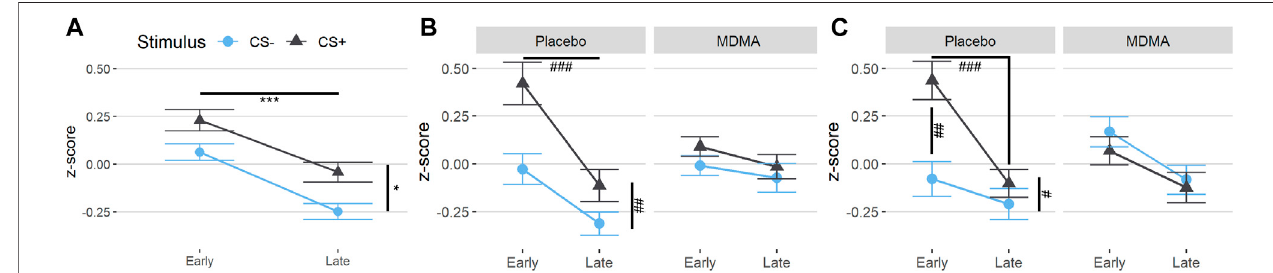
FIGURE 2 | MDMA treatment reduces CS+/CS − discrimination during fear extinction learning and enhances extinction recall. Standardized values (z-scores) of both trial types (conditioned fear stimulus [CS+] and conditioned safety stimulus [CS − ]) of the skin conductance response task. (A) Subjects showed differentiation between CS+ and CS − in acquisition. (B) In the extinction learning phase, subjects after a placebo displayed discrimination of the conditioned stimuli in the early phase and extinction over time, but already early nondiscrimination of the conditioned stimuli after MDMA. (C) In the recall phase, subjects after the placebo displayed an